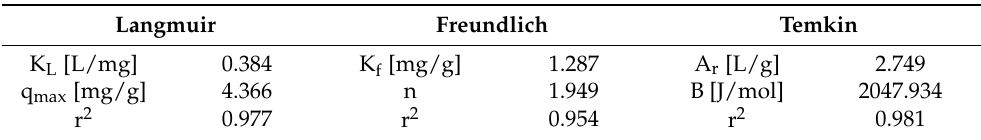
Figure 7. Non-linear isotherms for NH 4 -N adsorption on MSSB at different initial NH 4 -N concentrations. Table 5. Parameters of Langmuir, Freundlich, and Temkin isotherm models for NH 4 -N adsorption onto